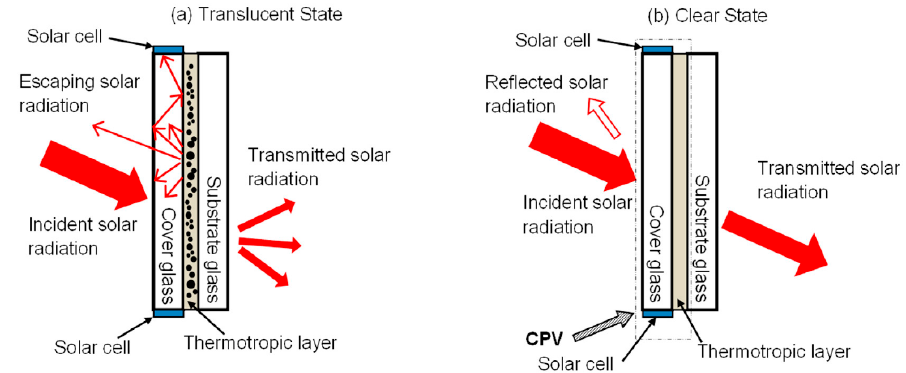
Figure 27. The thermotropic smart glazing along with PV layer in ( a ) translucent and ( b ) clear states [92].